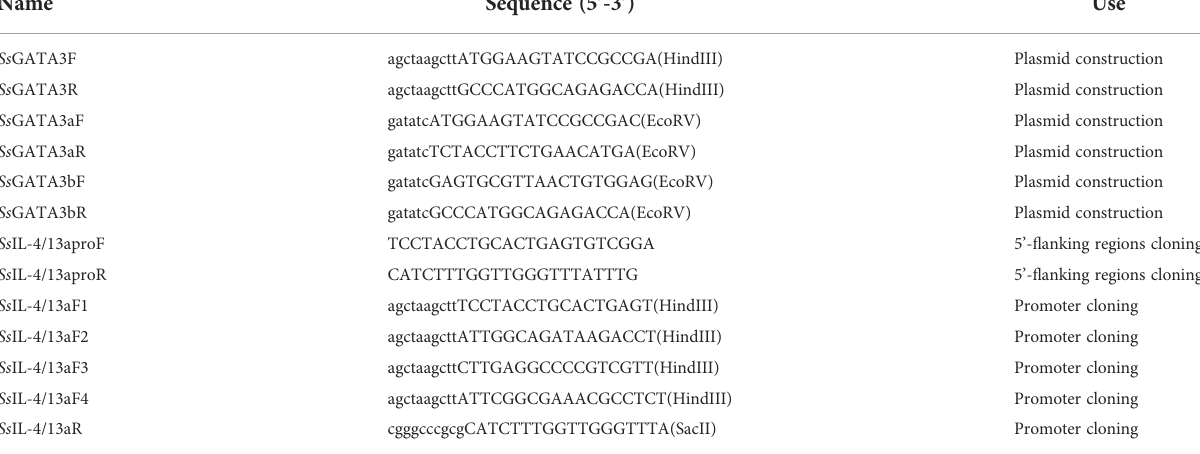
TABLE 1 Primers that were used in this